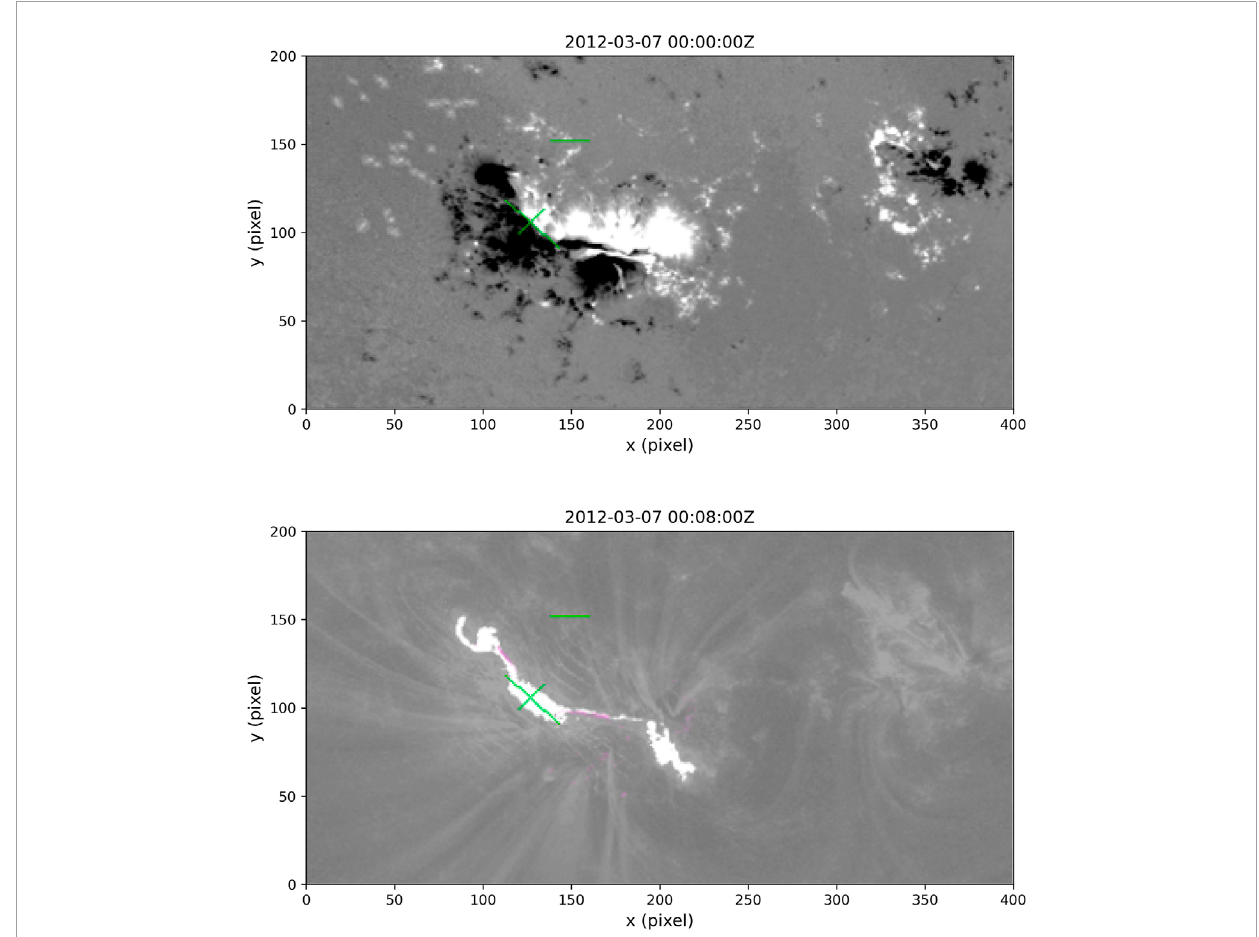
FIGURE 8 2012-03-07 00:00UT magnetogram (Top) and 00:08UT AIA overlay image (grayscale) with OR represented by purple shading (Bottom). The green lines indicate the locations where the vertical twist maps were calculated, across and along the PIL, as well as in area of quieter magnetic activity (upper